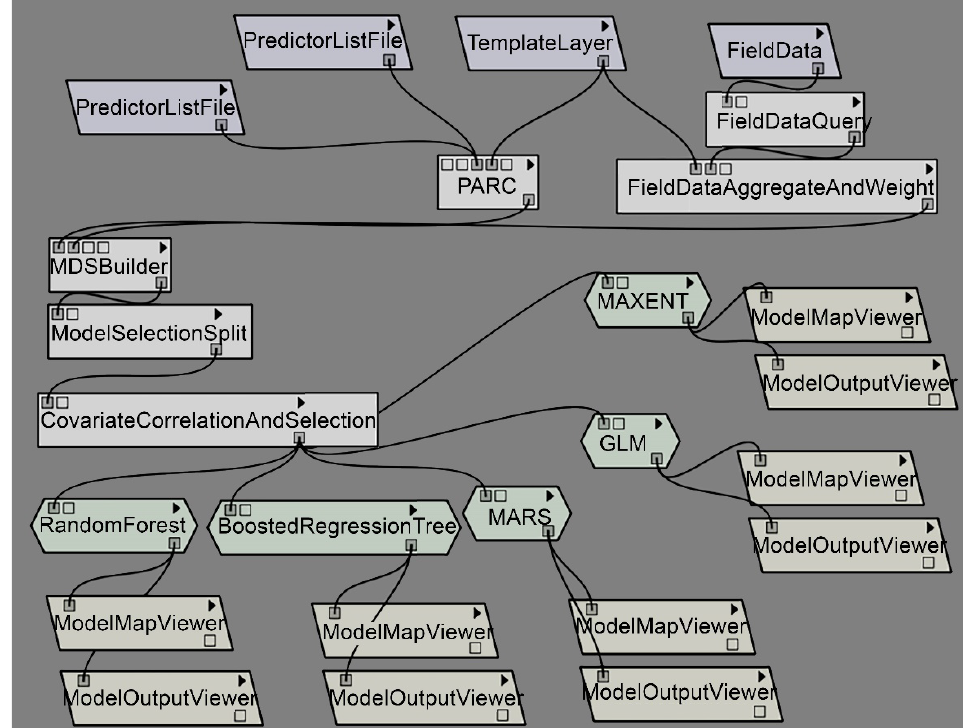
Figure 3. VisTrails v.2.2.3 pipeline with the SAHM v.2.0.1 (Software for Assisted Habitat Modeling) for this specific study.